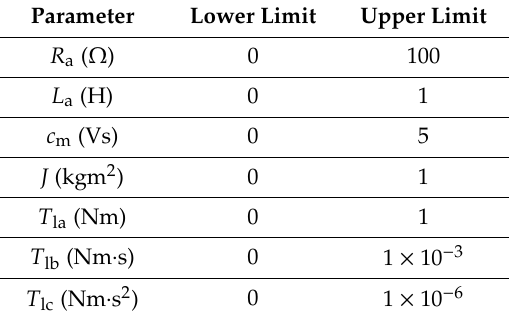
Table 4. Limits of the parameters.